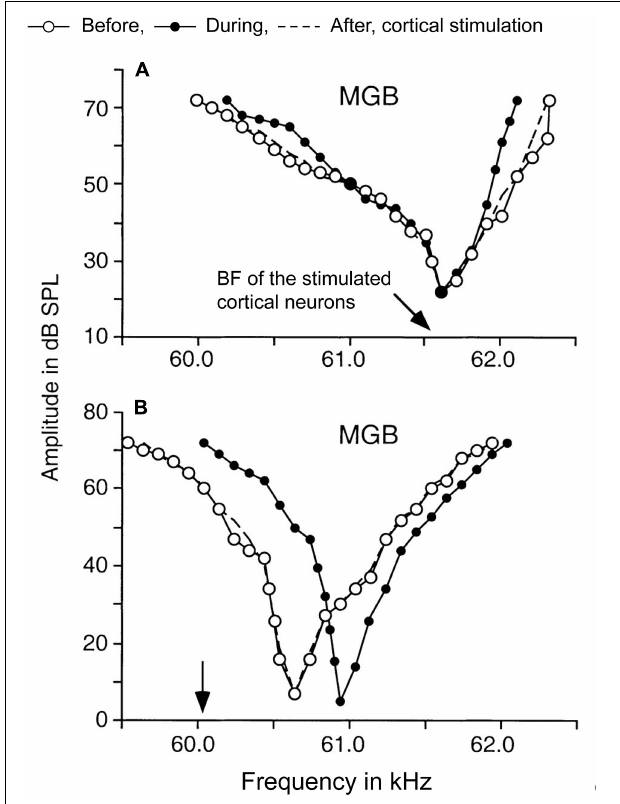
FIGURE 3 | Corticothalamic modulation of frequency tuning curves in MGBv neurons. A focal electrical activation of cortical neurons in the Doppler-shifted constant frequency processing area of Jamaican mustached bats evoked changes of frequency tuning curves in MGBv neurons. The black arrows indicate the best frequencies (BFs) of cortical neurons stimulated. The tuning curves were estimated before (white circles), during (black circles), and after (dashed lines) the cortical stimulation. (A) A MGBv neuron showed sharpening of the tuning curve when cortical neurons that had matched BF to the recipient MGBv neuron. BF of the MGBv neuron did not change. (B) Another MGBv neuron showed a reduction of responses around BF of the MGBv neuron when BF of stimulated cortical neurons is unmatched to the recipient MGBv neuron. The tuning curve was shifted away from the BF of stimulated cortical neurons with increasing responses outside of BF of the MGBv neuron. The changes were transient only lasting 1–2 h after the 7-min cortical stimulation (Adapted and modified with permission from Zhang and Suga, 2000; Figure